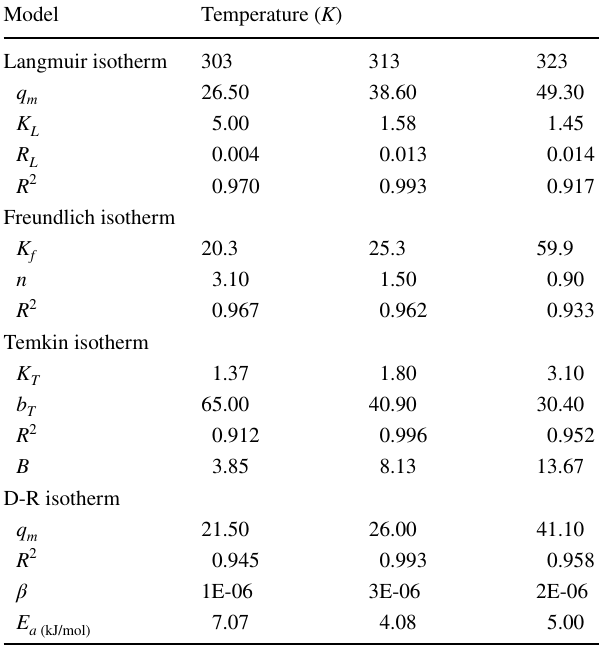
Table 3 Isotherm parameters for IBP adsorption onto OPA at differ- ent temperatures Model